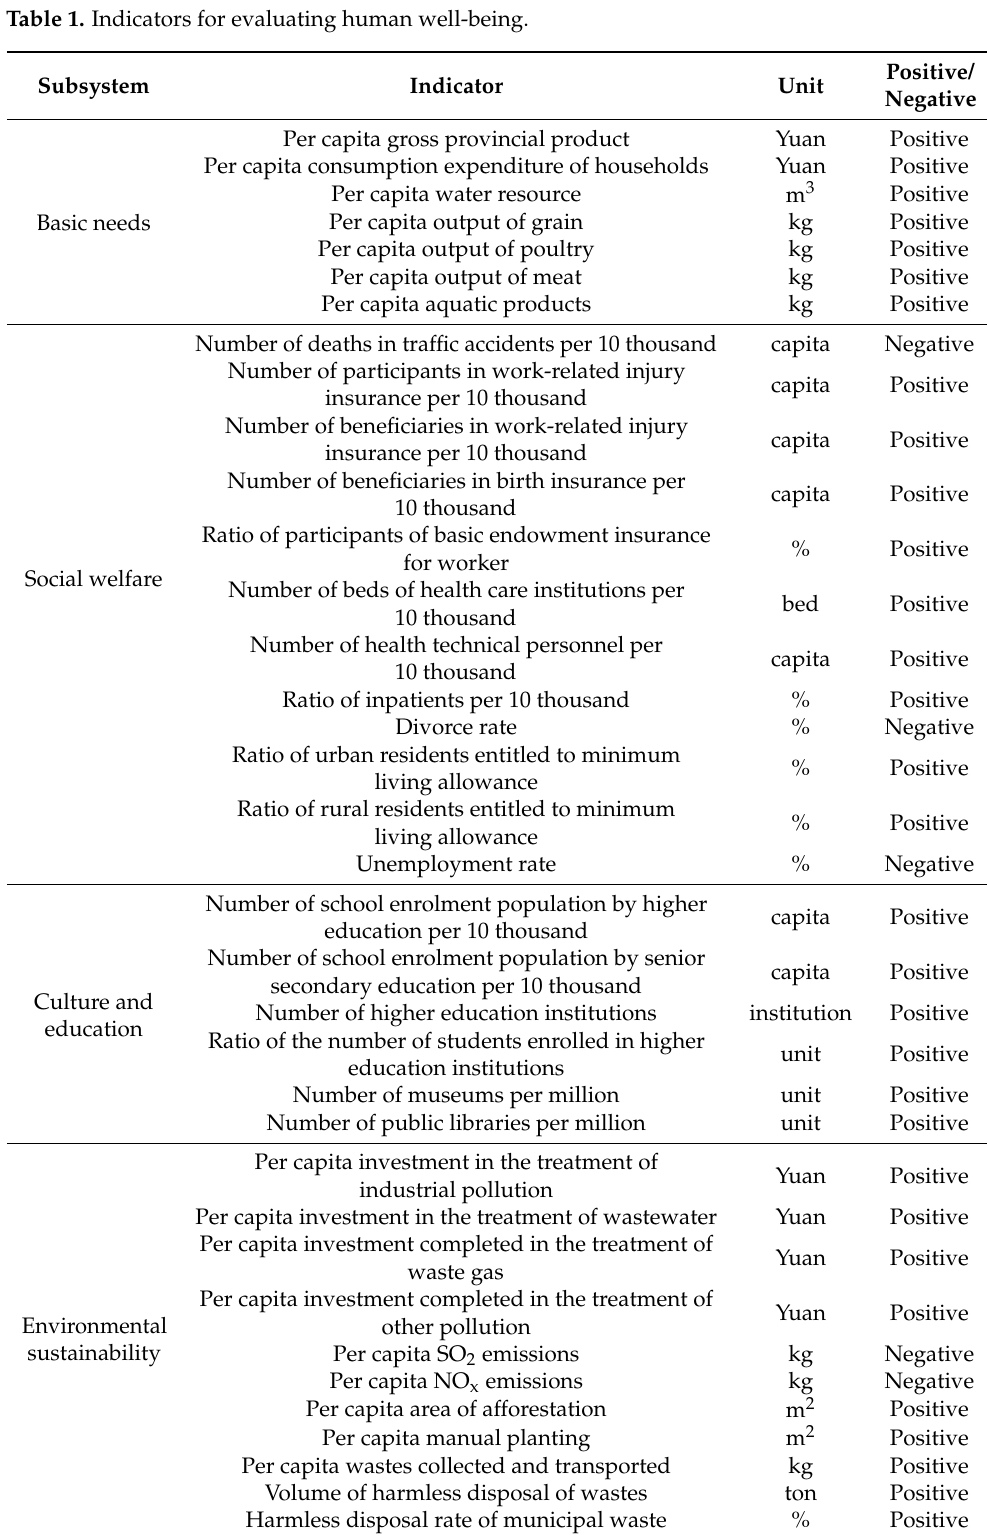
Table 1. Indicators for evaluating human